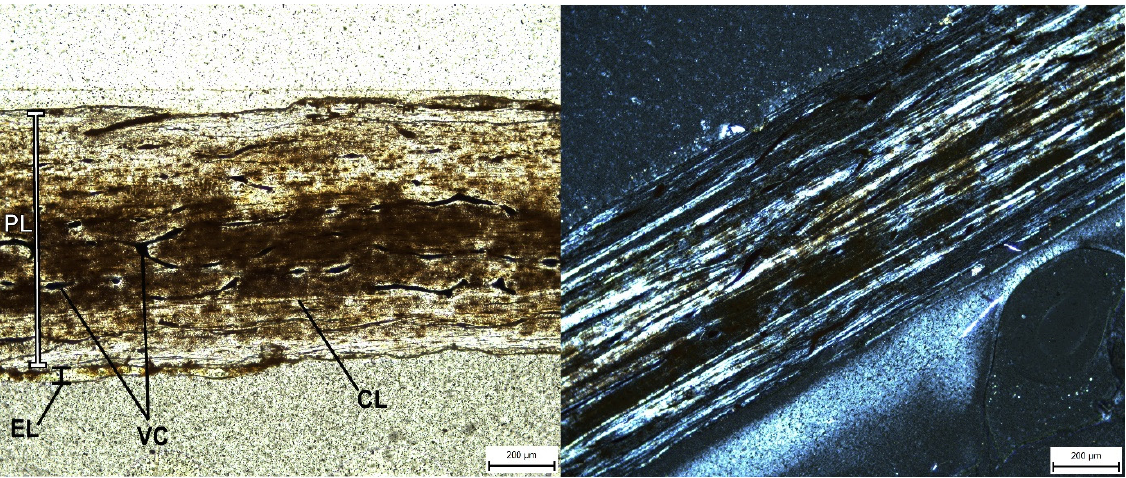
Figure 10. Thin section of MGUAN-PA653 ulna fragment under normal light ( left ) and cross-polarized light ( right ). Abbreviations: CL, circumferential lamella; EL, endosteal layer; PL, periosteal layer; VC, vascular canals.